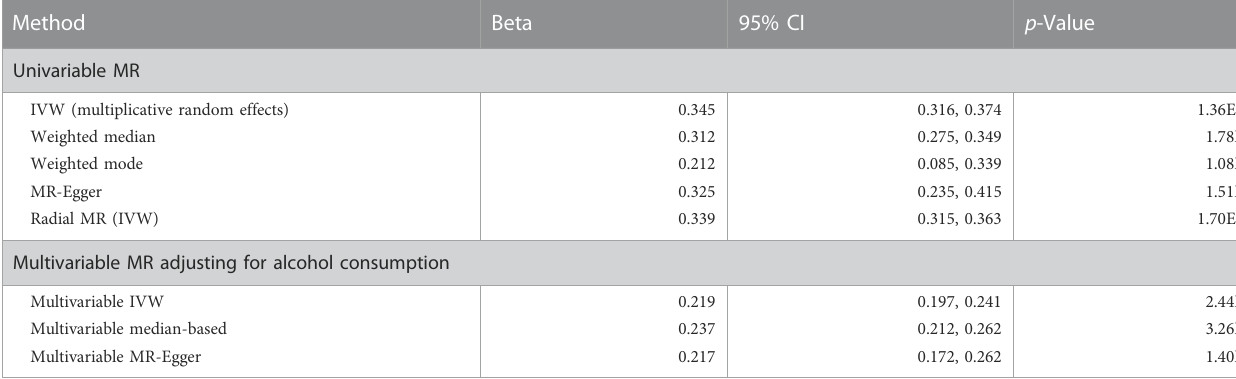
TABLE 1 MR results for the effect of smoking initiation on the frailty index.